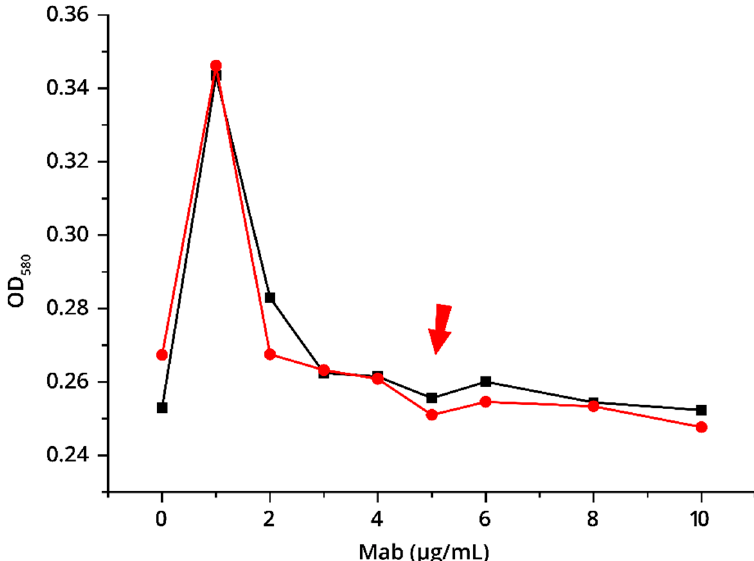
Figure 2. Choice of the concentration of specific antibodies used for conjugation with GNPs (OD 520 = 1.0): black line—antibody IS7, red line—antibody 6F9. The selected antibody concentration (marked by the arrow) was 5 μ g/mL.